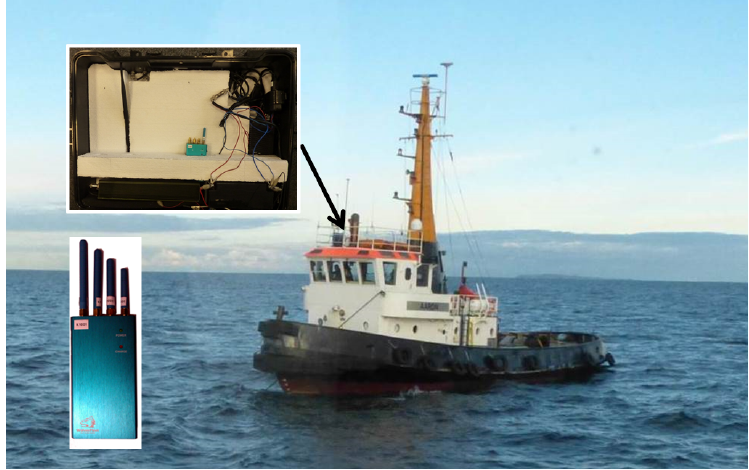
Figure 2. AARON with the jammer mounted on the monkey